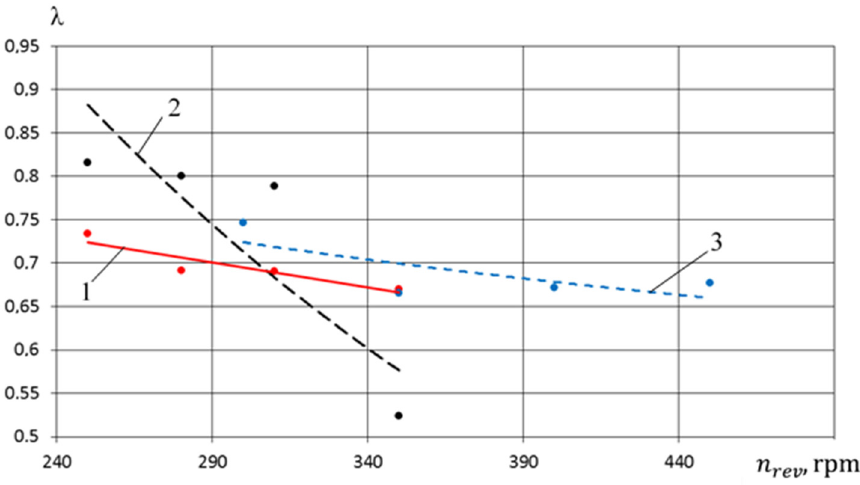
Figure 38. Dependence of the supply coefficient of the compressor section on the angular velocity of the crankshaft (1—PHPM with step-type gap seals; 2—PHPM with smooth gap seals; 3—Crosshead-free PHPM).